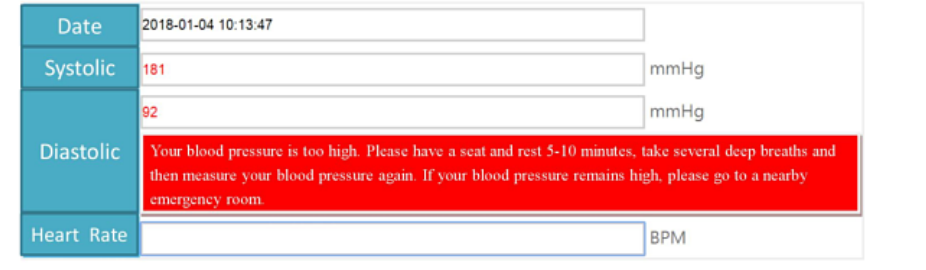
Figure 2. Screenshot of the medication reminder area and medication titration area.